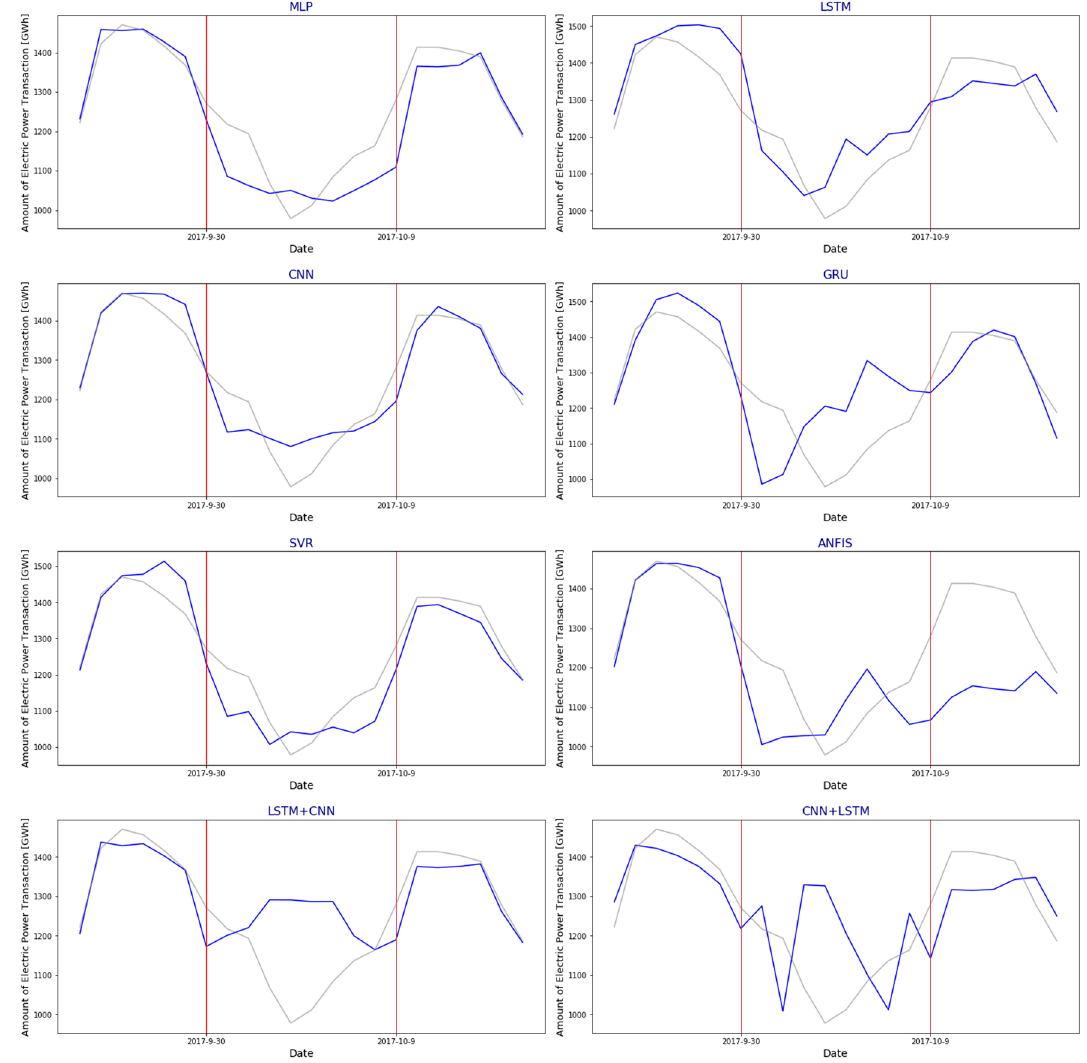
Figure 31. Comparison of special day (holiday season) patterns with different algorithms.